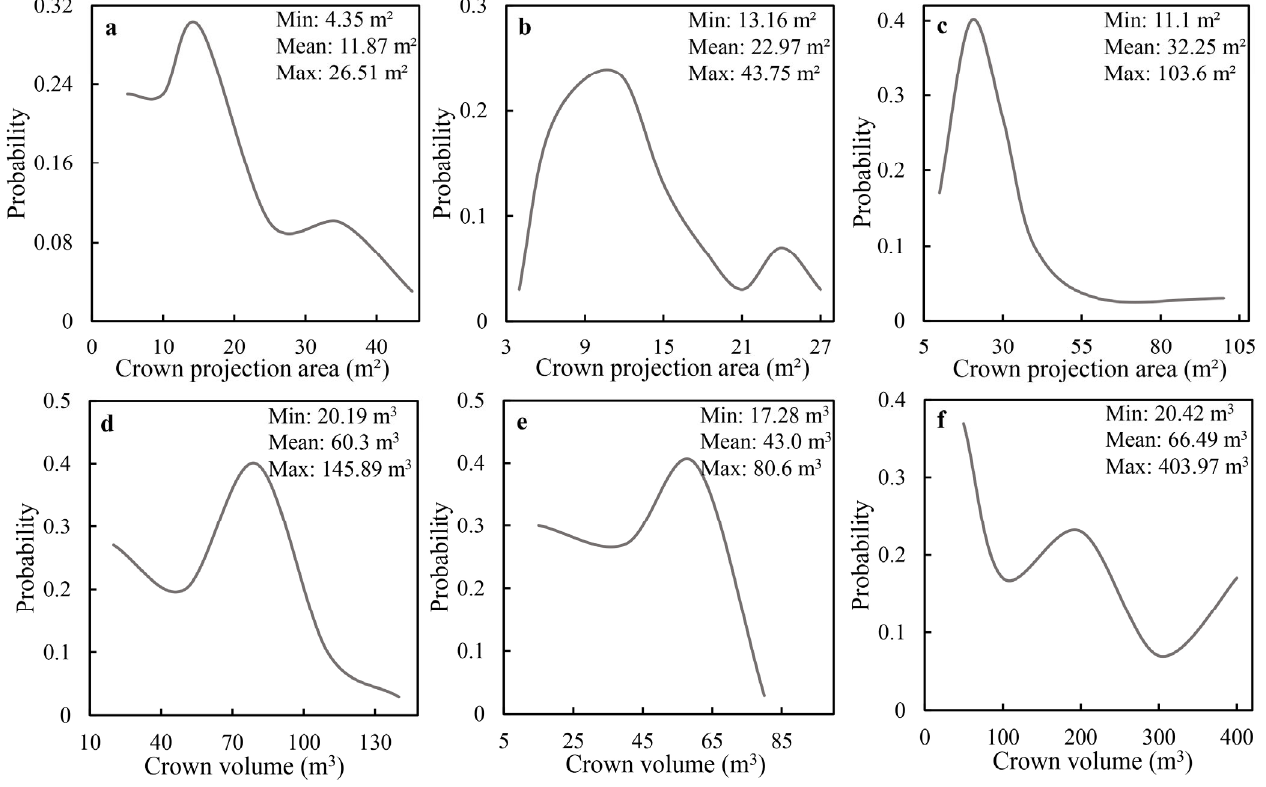
Figure 9. The crown projection area and volume of Douglas fir ( a , d ), Red alder ( b , e ), and Bigleaf maple ( c , f ).